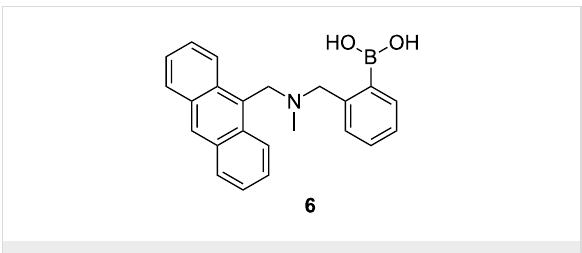
Figure 4: Fluorescence PET sensor for saccharides.